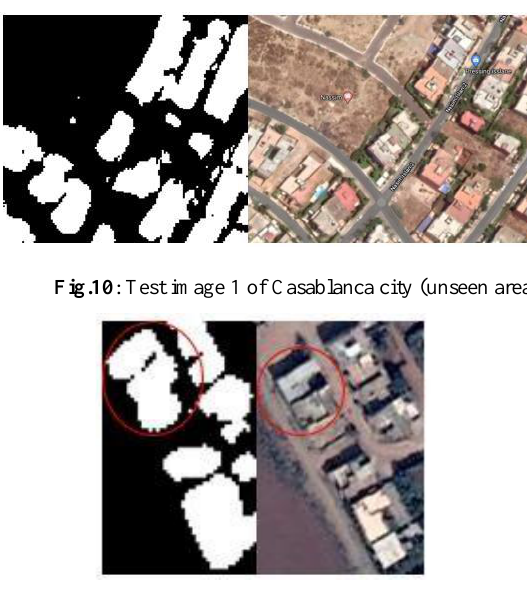
Fig.11 : Test image 2 of bouskoura (unseen areas)